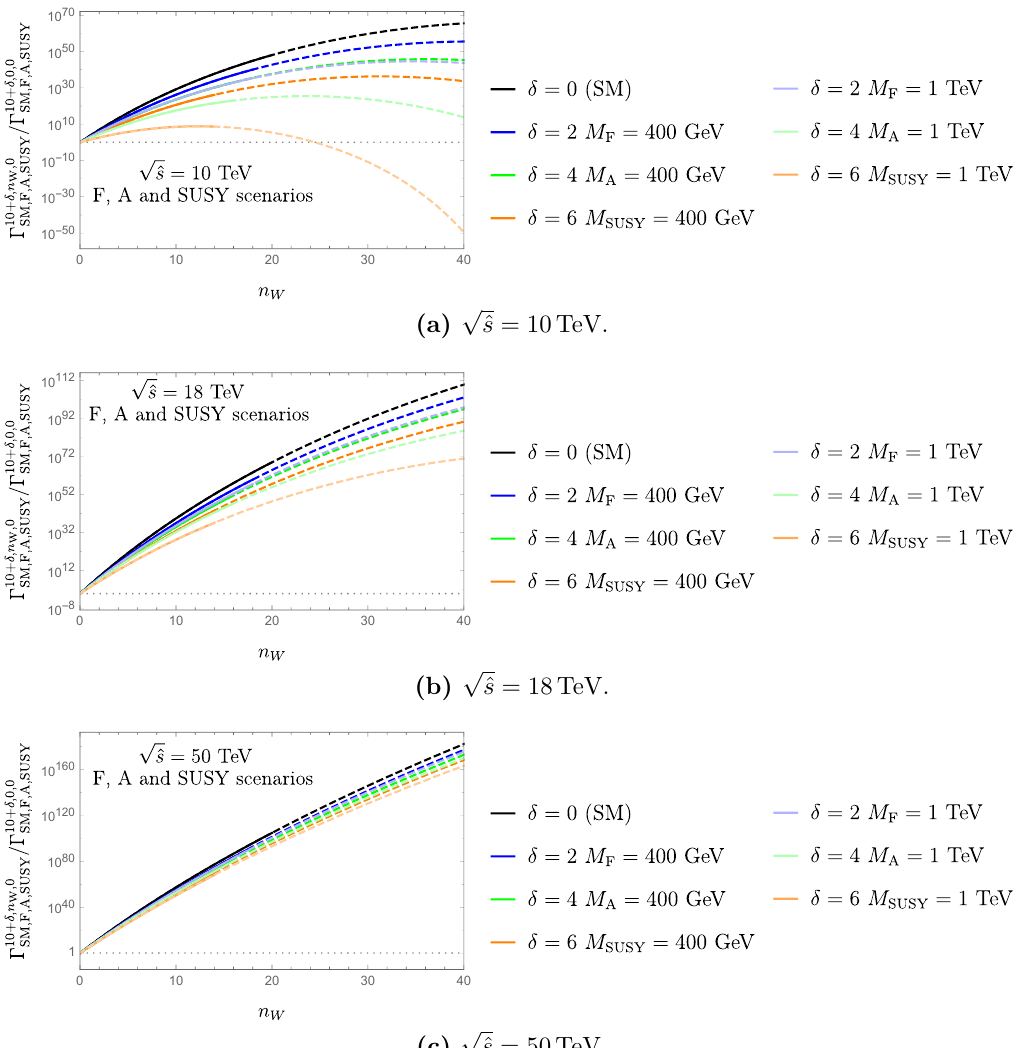
p ^ s and new fermion masses M